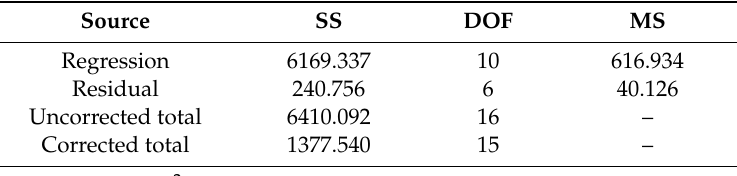
Table 6. ANOVA for the response surface model of α X .